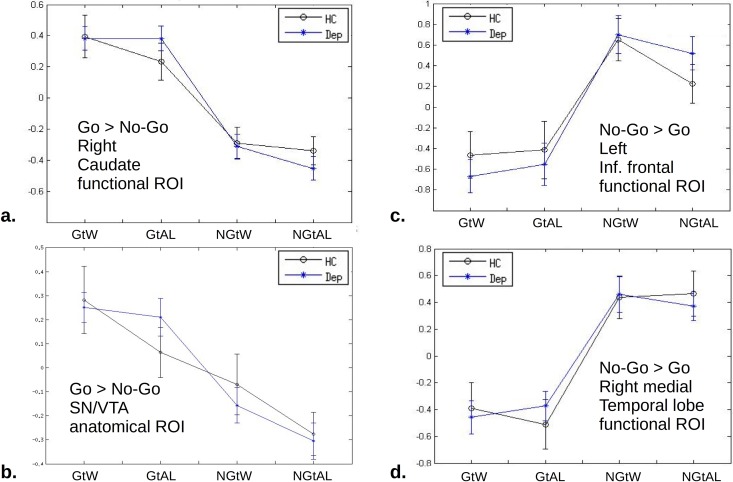
Comparisons of Healthy vs. Depression activations in specific ROIs hypothesized to be important for motivated action.Means and standard errors are shown for each of the four sets of trials. No area showed differences between depression (blue) and control (black). a. Right Caudate region of interest defined as the cluster significant at 5% FWE for the main effect of action over the entire sample. The ‘Go’ conditions have greater activation by construction, but no other differences are seen. b. As an example, this ROI is an anatomically predefined mask for Substantia Nigra / Ventral Tegmental Area. It is a subset of the cluster indicated by cross-hairs in Fig 4A. The win–avoid-loss difference is not statistically significant. c. Inferior frontal ROI defined by functional criteria (as per a.) of greater activation for holding back (‘No-Go’). d. As per (c.) but for amygdala/hippocampal cluster.